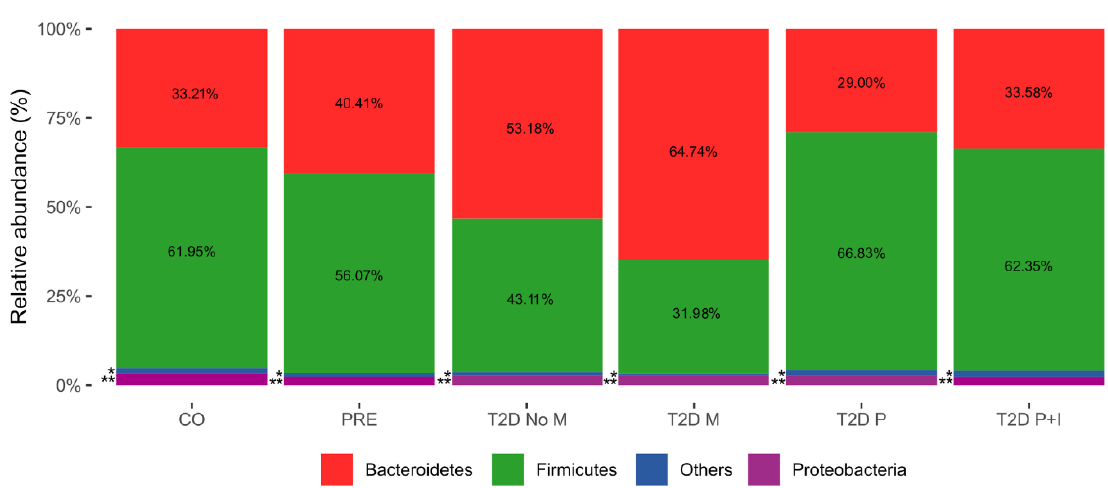
Figure 1. Bacterial phyla abundances. The bar charts of the figure show the relative abundances (%) of relevant bacterial phyla from the gut microbiota in the six groups studied in this work. Control (CO), Prediabetes (PRE), T2D no medicated (T2D − No − M), T2D with Metformin (T2D − M), T2D with polypharmacy (T2D − P), and T2D with polypharmacy + insulin (T2D − P + I). Phyla are identified by colors as indicated underneath the bars. “Others” includes phyla such as Actinobacteria, Tenericutes, Cyanobacteria, and Fusobacteria. One asterisk (*) for Others indicates abundance of 1.50% for CO, 1.10% for PRE, 0.92% for T2D − No − M, 0.63% for T2D − M, 1.51% for T2D − P, and 1.69% for T2D − P + I. Two asterisks (**) for Proteobacteria indicates abundance of 3.34% for CO, 2.42% for PRE, 2.79% for T2D − No − M, 2.65% for T2D − M, 2.66% for T2D − P, and 2.38% for T2D − P + I (see Materials and Methods, and Table